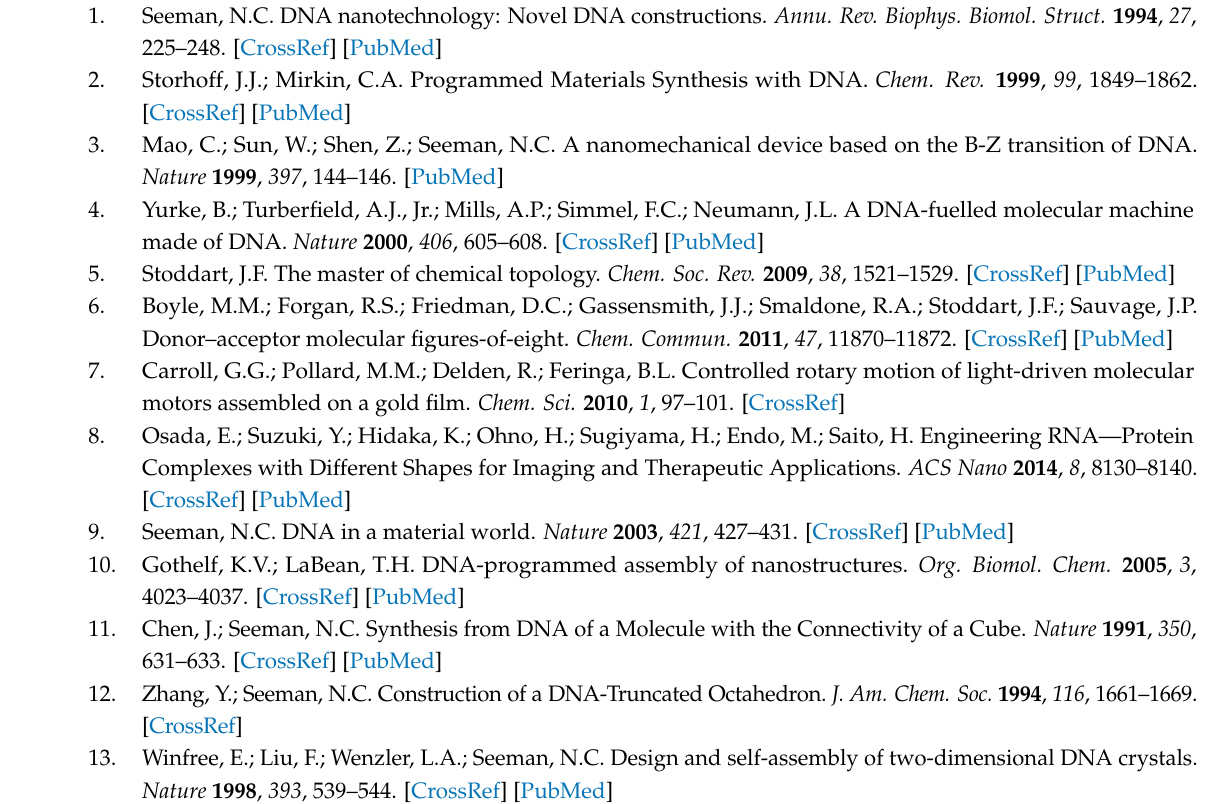
study, TEM and AFM images of MYC and the